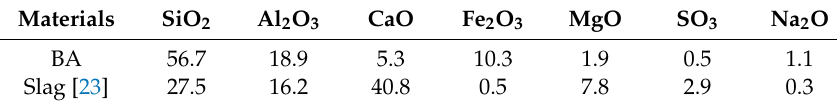
Table 1. Main chemical composition of raw materials